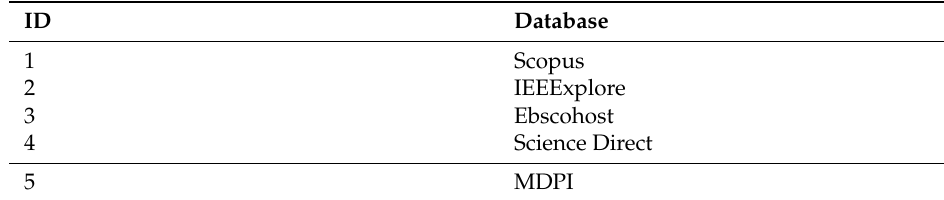
Table 2. List of used databases.